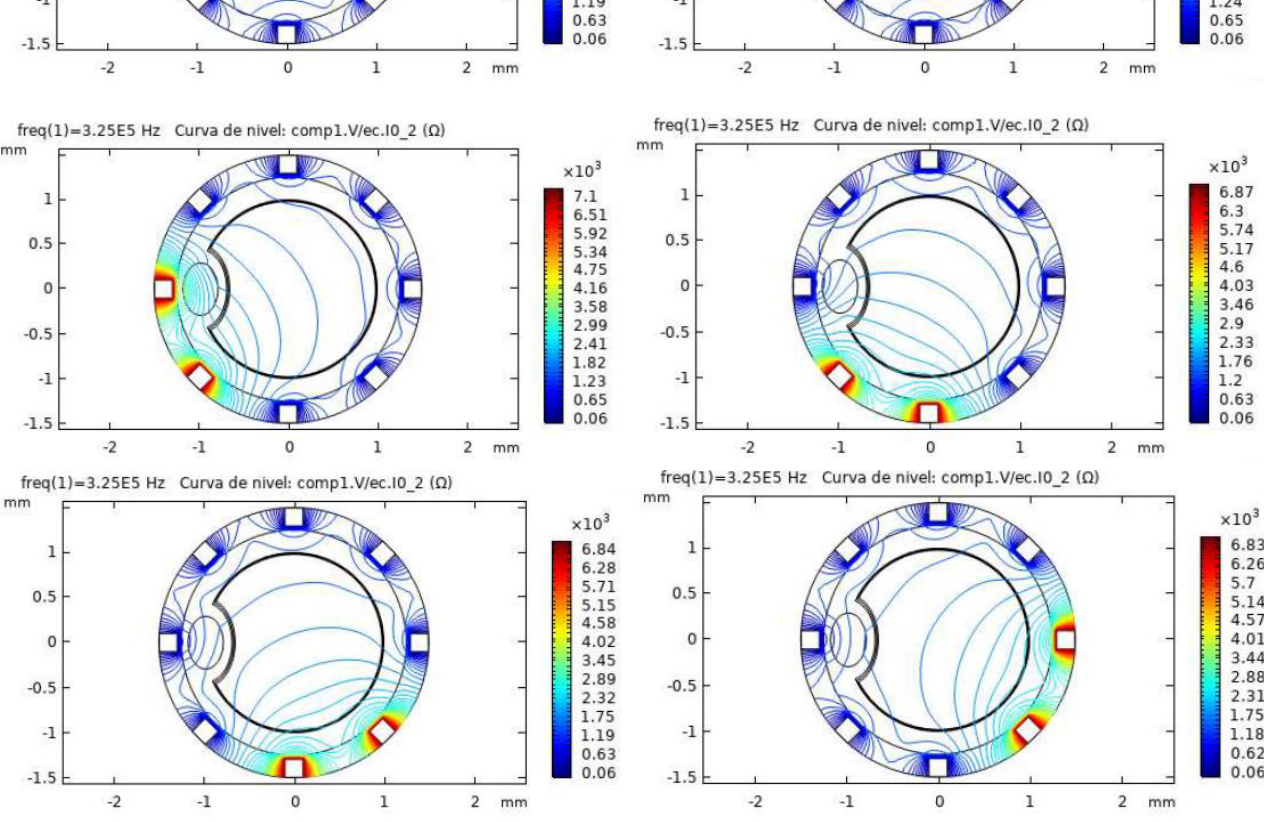
Figure 6. Simulation results for the pathological model in different configurations. The level curves for Impedance (ohms) obtained in COMSOL are shown. The atheroma generates a disturbance in the electric fields, as it can be seen near the left electrode for the different configurations.